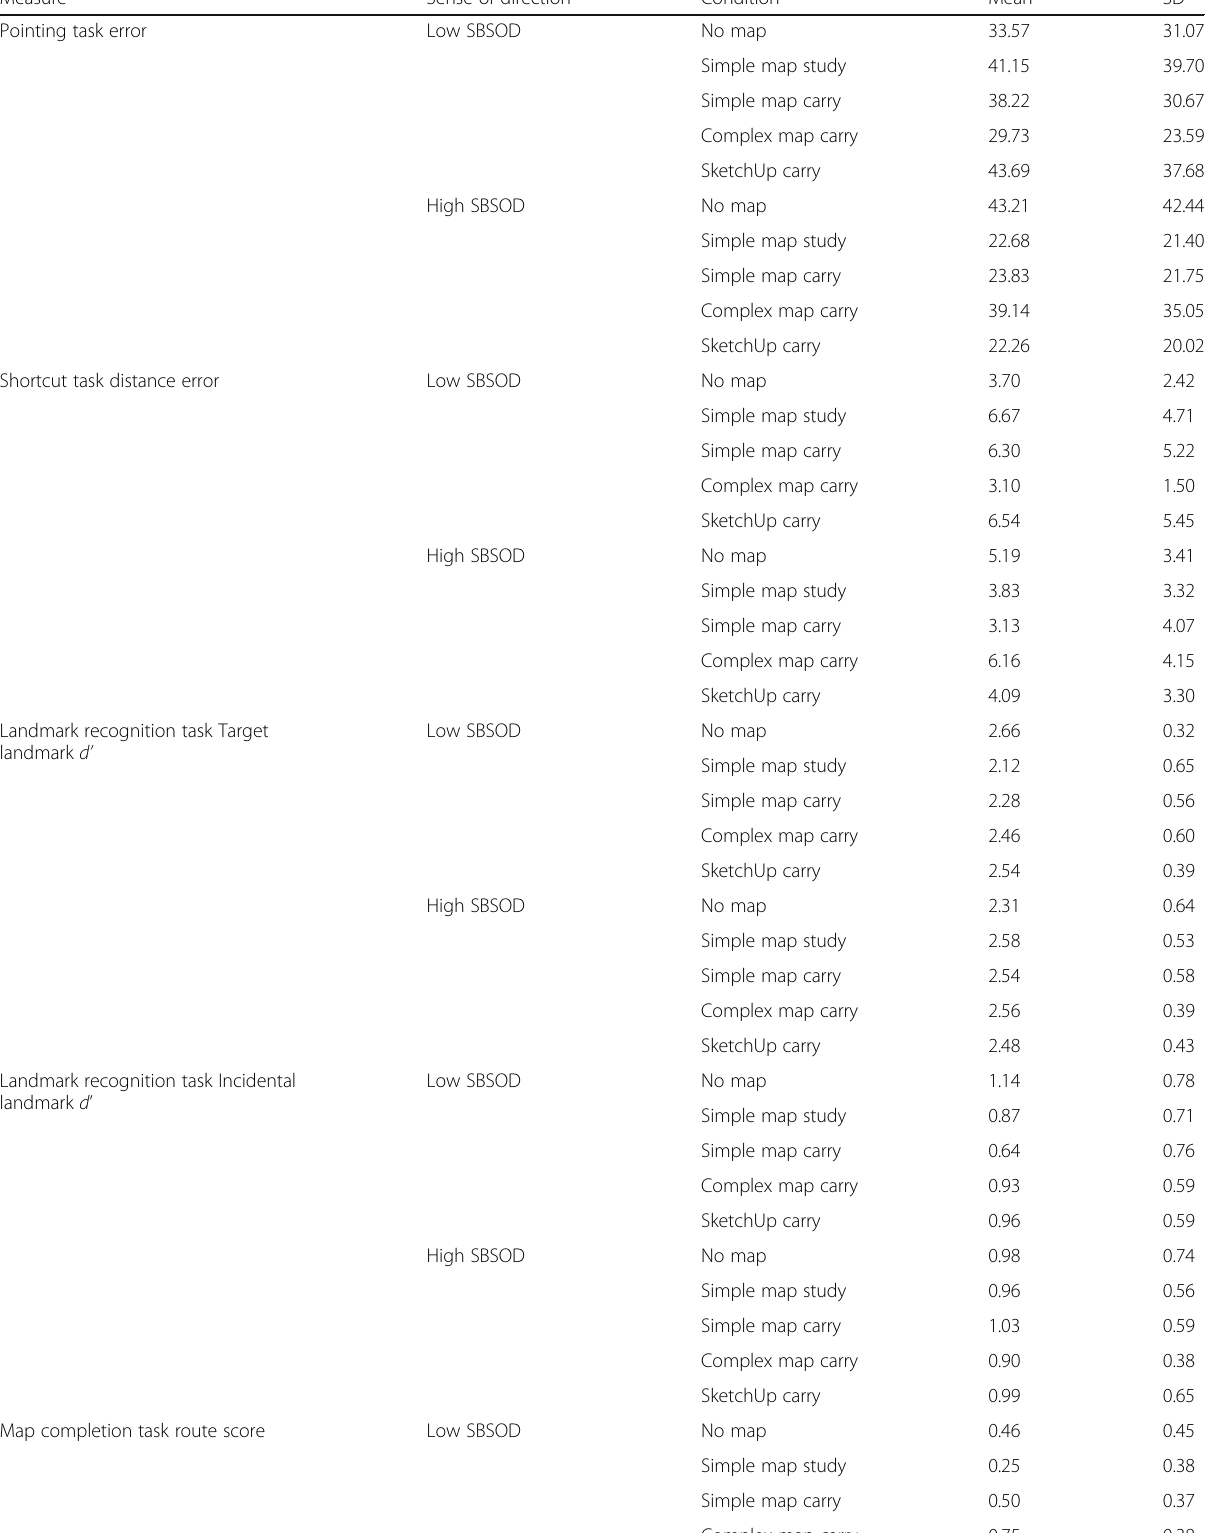
Table 4 Mean values and standard deviations (SDs) for each measure, split by map condition and sense of direction Measure Sense of direction Condition Mean SD Pointing task